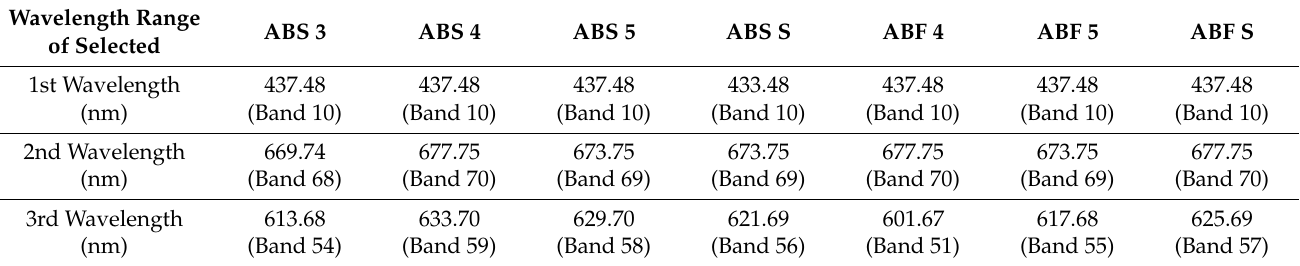
Table 4. Absorption wavelength range of selected blue-green